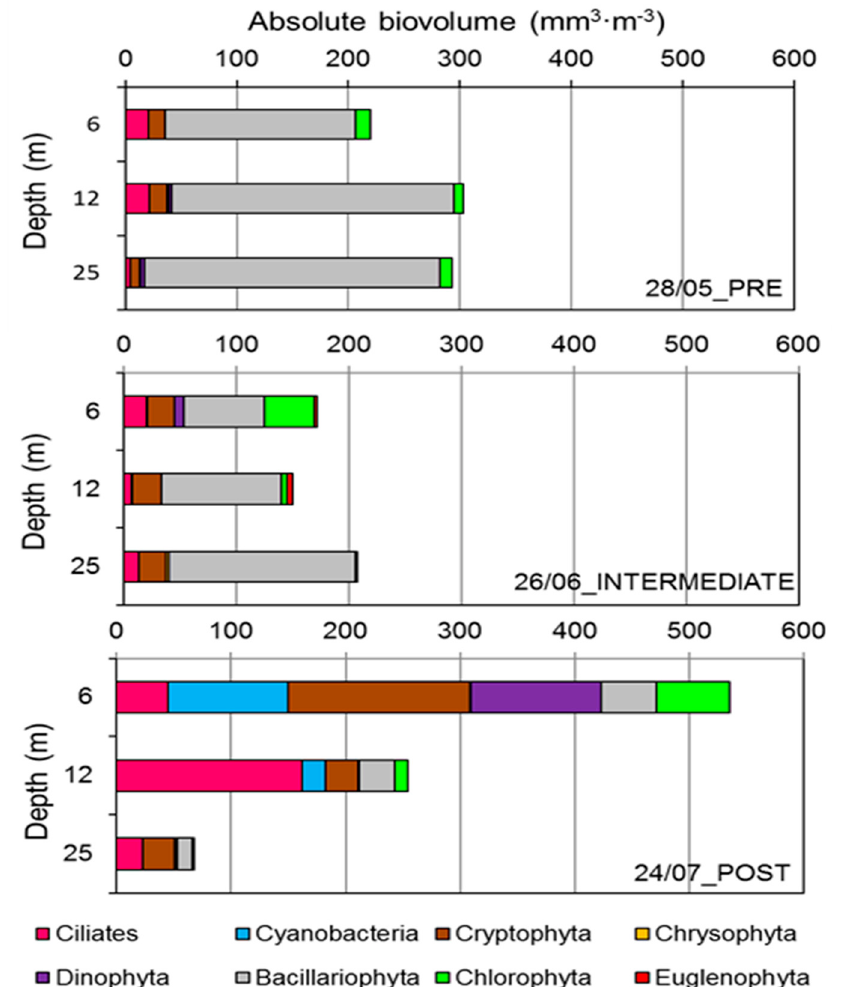
Figure 7. Biovolumes (mm 3 ·m − 3 ) of different phytoplankton phyla and ciliates recorded at different depths in Lough Feeagh on each specific date (pre-, intermediate and post-storm event). Samples at 6 m (integrated water sample from the surface) correspond to epilimnion, samples at 12 m correspond to metalimnion and samples at 25 m correspond to hypolimnion of Lough Feeagh.